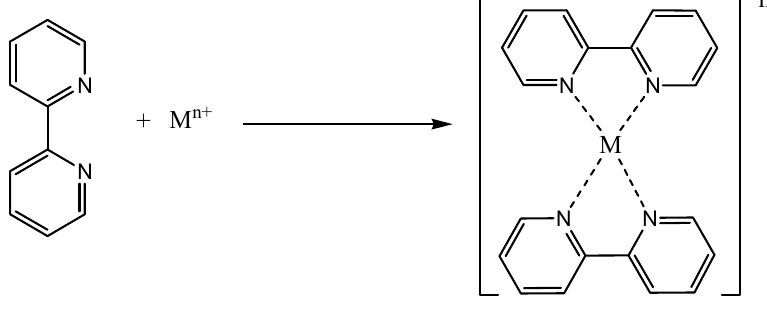
Figure 21. Synthesis of transition metal complexes .